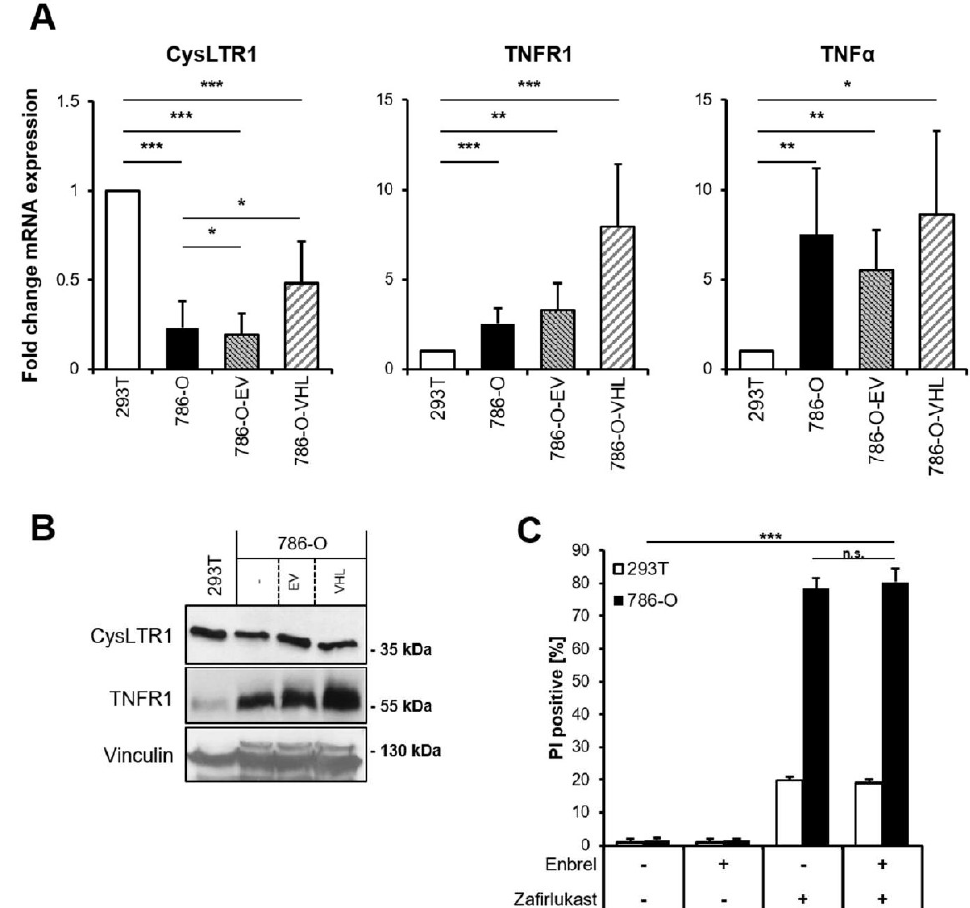
Figure 2. TNF α does not affect zafirlukast-induced cell death. ( A ) mRNA expression levels of CysLTR1 , TNFR1 and TNF α in the indicated cell lines were determined using qRT-PCR. Data are normalized to GAPDH expression and presented as x-fold mRNA expression compared to control. Mean and SD of four independent experiments performed in triplicate are shown. * p < 0.05, ** p < 0.01, *** p < 0.001; ( B ) Western blot analysis of CysLTR1 and TNFR1 expression in 293T, 786-O, 786-O-EV and 786-O-VHL cells. Vinculin serves as loading control. Representative blots of at least three different independent experiments are shown; ( C ) 786-O and 293T cells were pre-treated with 100 µg/mL of Etanercept (Enbrel) for 1 h, followed by treatment with DMSO or 100 µM zafirlukast for 24 h, after which cell death was determined by quantifying PI uptake. Data are presented as percentage of PI-positive cells and mean and SD of three independent experiments performed in triplicate are shown. *** p < 0.001, n.s.: non-significant.